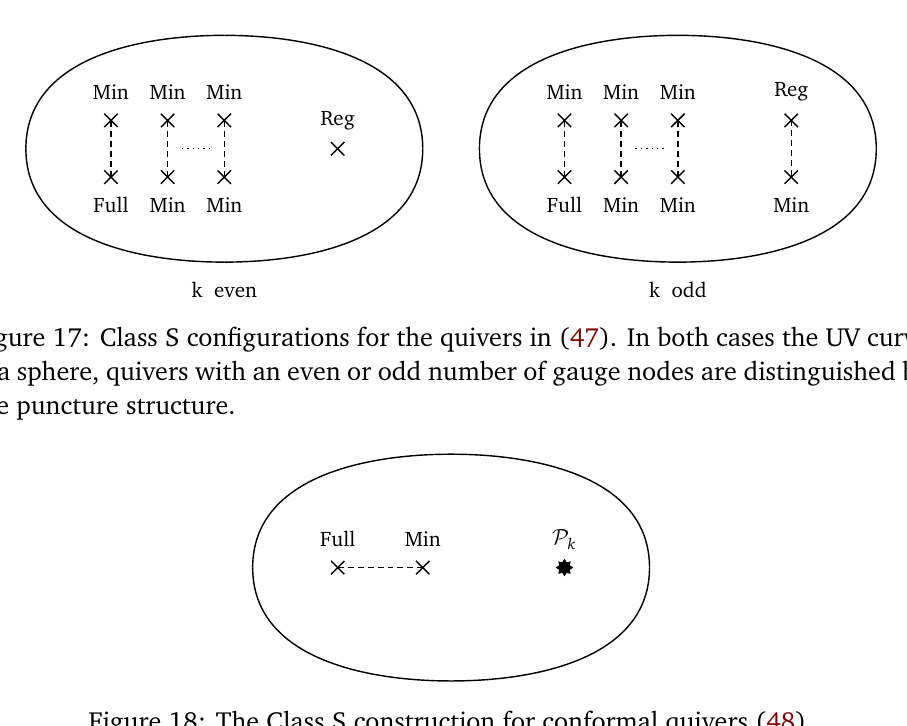
Figure 18: The Class S construction for conformal quivers